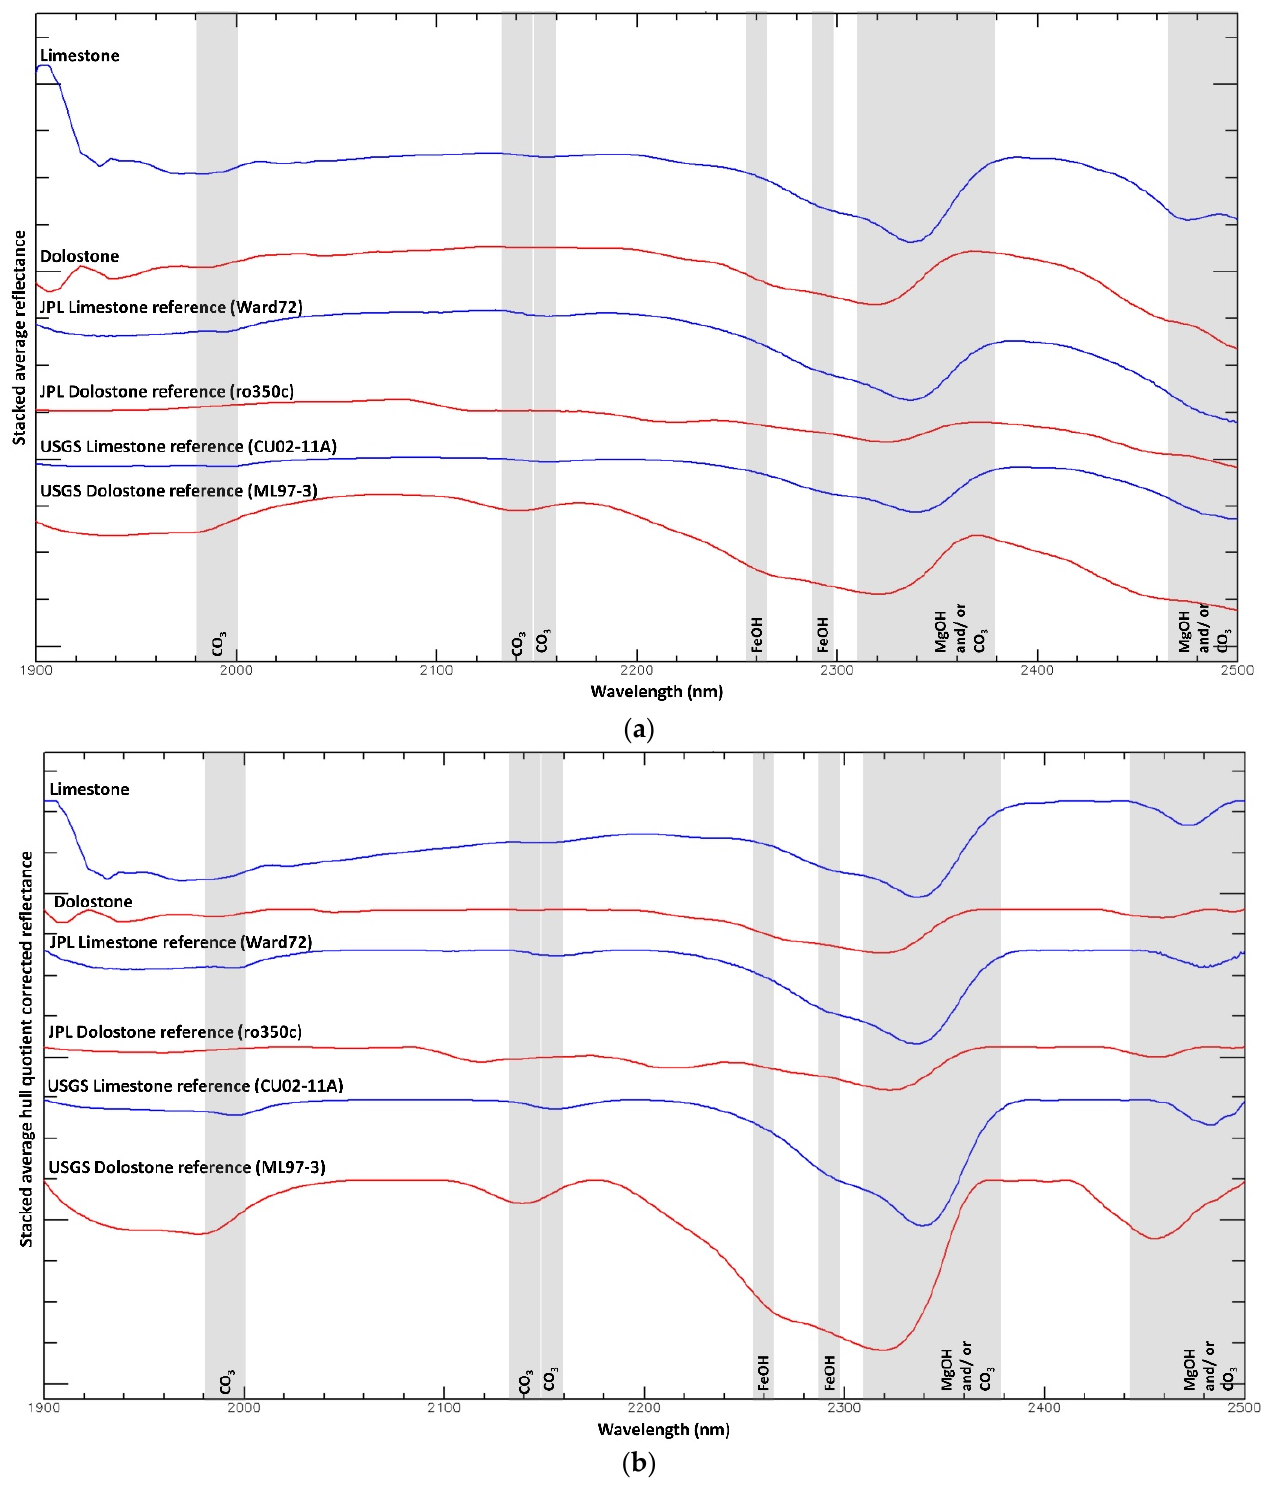
Figure 6. Stacked average surface reflectance of limestone and dolostone of the target outcrop compared with library reference spectra ( a ) and the average hull quotient corrected reflectance spectra of limestone and dolostone compared with library reference spectra ( b ).